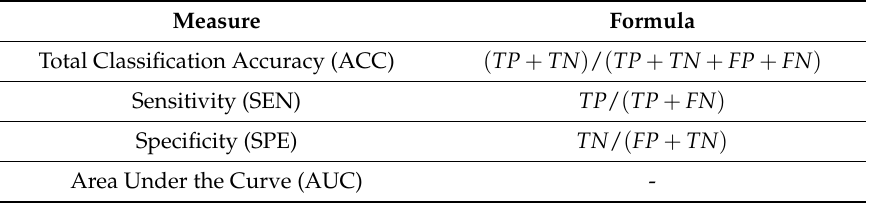
Table 2. Binary performance